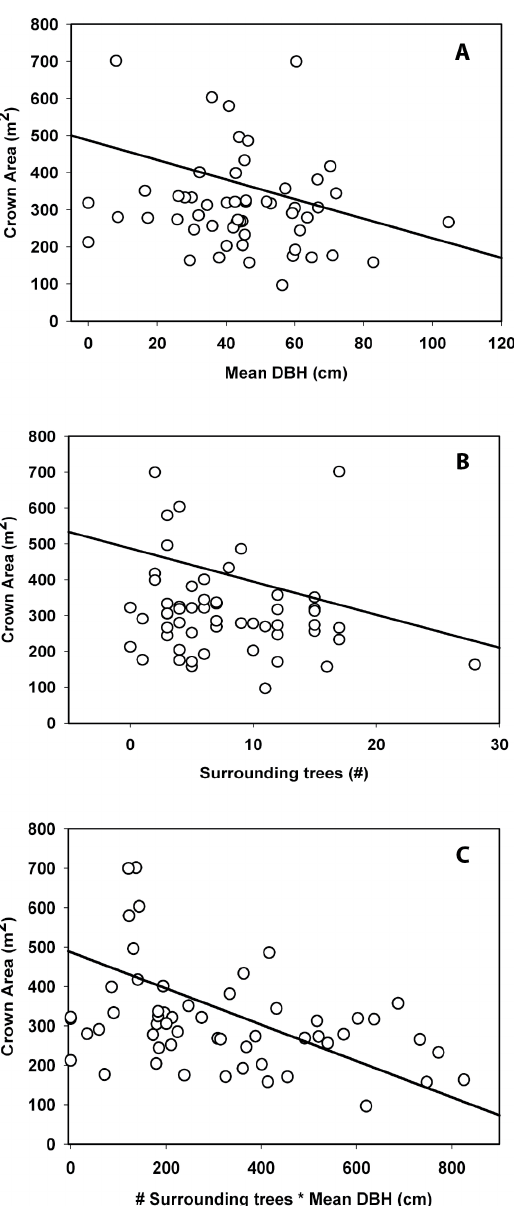
Fig. 3 . (A) The effect of mean diameter at breast height (DBH) of surrounding trees on specimen oak crown area (F = 7.33, 1, 51 p = 0.009); (B) The effect of the number of surrounding trees on specimen oak crown area (F = 7.58, p = 0.008); and (C) 1, 51 The effect of the interaction between mean DBH of surrounding trees and the number of surrounding trees on specimen oak crown area (F = 6.27, p = 1, 51